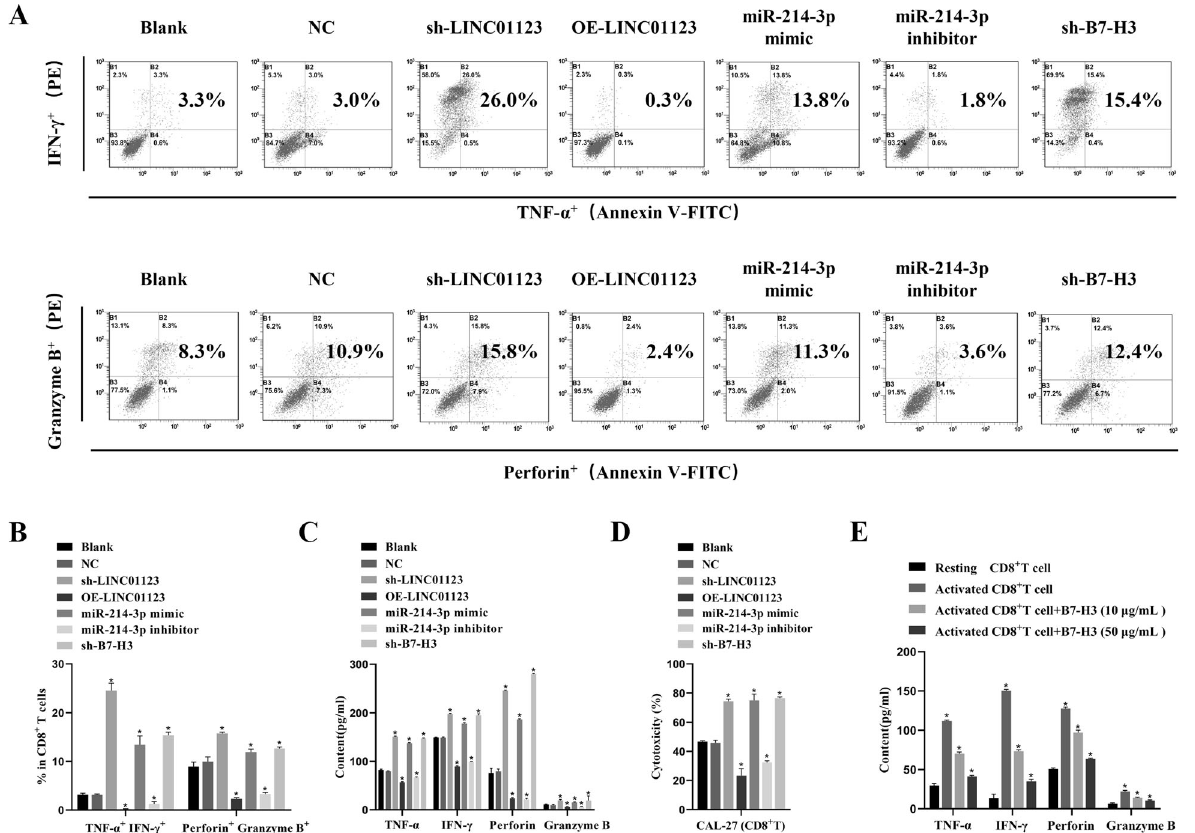
Fig. 4 Upregulation of LINC01123 or B7 – H3 or downregulation of miR-214-3p induces dysfunction of CD8 + T cells. CD8 + T cells were isolated from PBMCs using immunomagnetic beads. After activation and ampli fi cation, CD8 + T cells were cocultured with different CAL-27 cell treatment groups. A Expression of TNF- α , IFN- γ , perforin, and granzyme B in CD8 + T-cell population was analyzed with fl ow cytometry. B Statistical analysis of the results from fl ow cytometry of CD8 + T cells. C Expression levels of TNF- α , IFN- γ , perforin, and granzyme B in CAL- 27 – CD8 + T cocultured supernatants, as detected by ELISA. D CCK8 cytotoxicity test of CD8 + T cells. E ELISA was used to assess the immune activity of CD8 + T cells after recombinant human B7 – H3 treatment. * P < 0.05 compared with cells without treatment. The experiment was repeated three